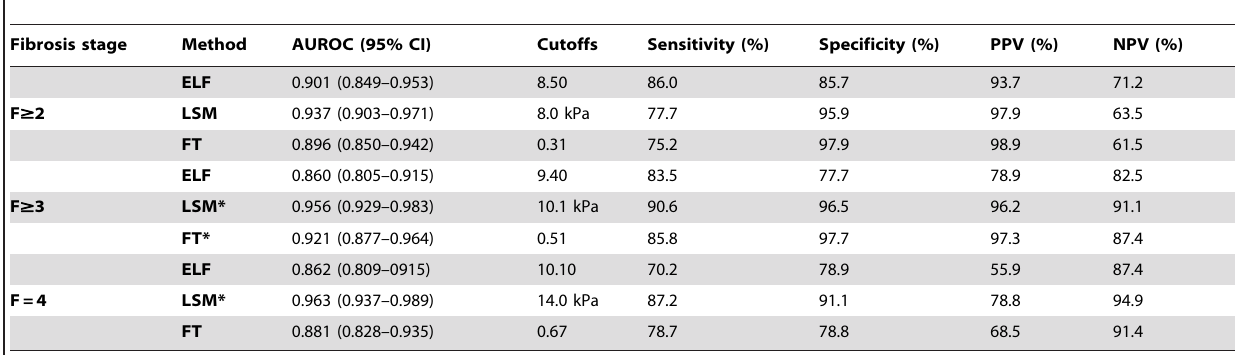
Table 2. Diagnostic performances of LSM, FT and ELF and their suggested optimal cutoff values.